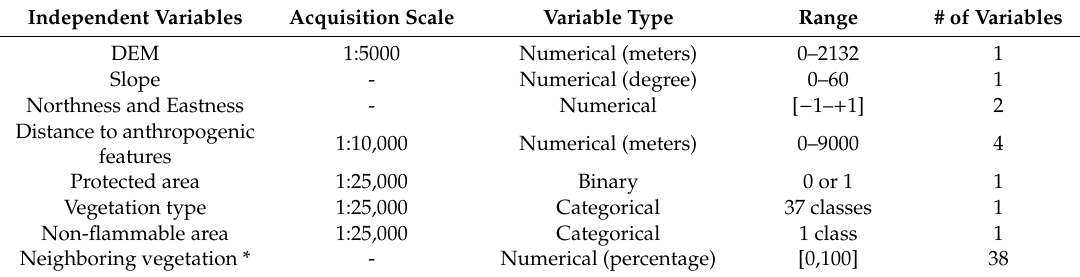
Table 1. Independent variables and their characteristics. (*) The neighboring vegetation was only included in the second model for comparison